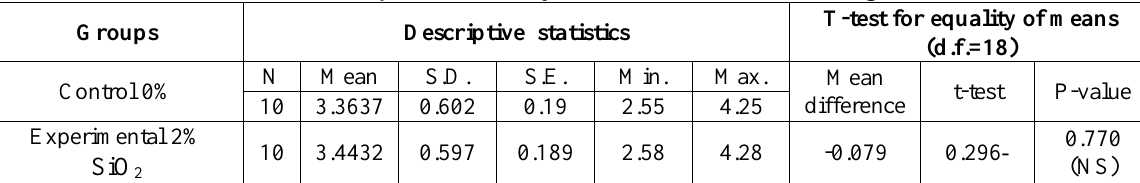
T-test for equality of means (d.f.=18)